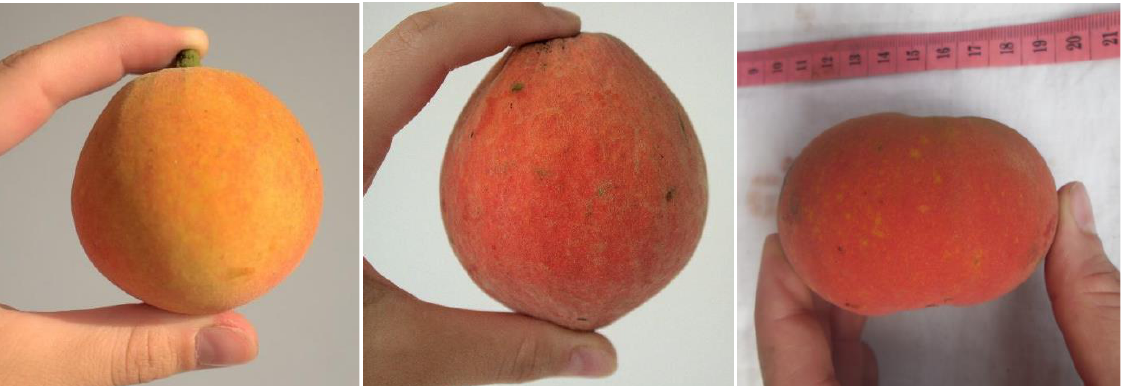
Figure 2. The most common shapes of G. kola fruit — spherical, ellipsoid, flattened (from left to right). In terms of diameter, the fruits were alike. The only differences appeared in the length of the fruits (Table 2). Major differences were noted in the weight of the fruits as a result of variations in the number of seeds, seed mass and seed mass ratio. The heaviest fruits were found in Bot-Makak and Sangmelima (226 ± 84.3 g and 235 ± 103 g, respectively), while the lightest appeared in Kye-Ossi and Akok (154 ± 52.8, 171 ± 63.8, respectively). The highest number of seeds per fruit, ≥ 3 on average, was detected in South study sites. The highest seed mass was reached in Lekie-Assi, Sangmelima and Zo é tel é (20.6 ± 9.37 g, 22.6 ± 9.18 g and 23.3 ± 6.90 g, respectively), differing especially from Akok, Bot-Makak and Kye-Ossi (13.0 ± 6.76 g, 12.9 ± 7.06 g and 14.8 ± 10.33 g, respectively). Calculating the proportion of the fruit pulp to the seed mass, the smallest score was reached in Akok, whereas the rest of the study sites were more or less similar, having around 10% seed mass. Table 2. Quantitative description of the fruits over geographic populations. Mean values and standard deviation (SD) supplemented with ANOVA (Tukey post hoc test) and t -test of statistical significance.